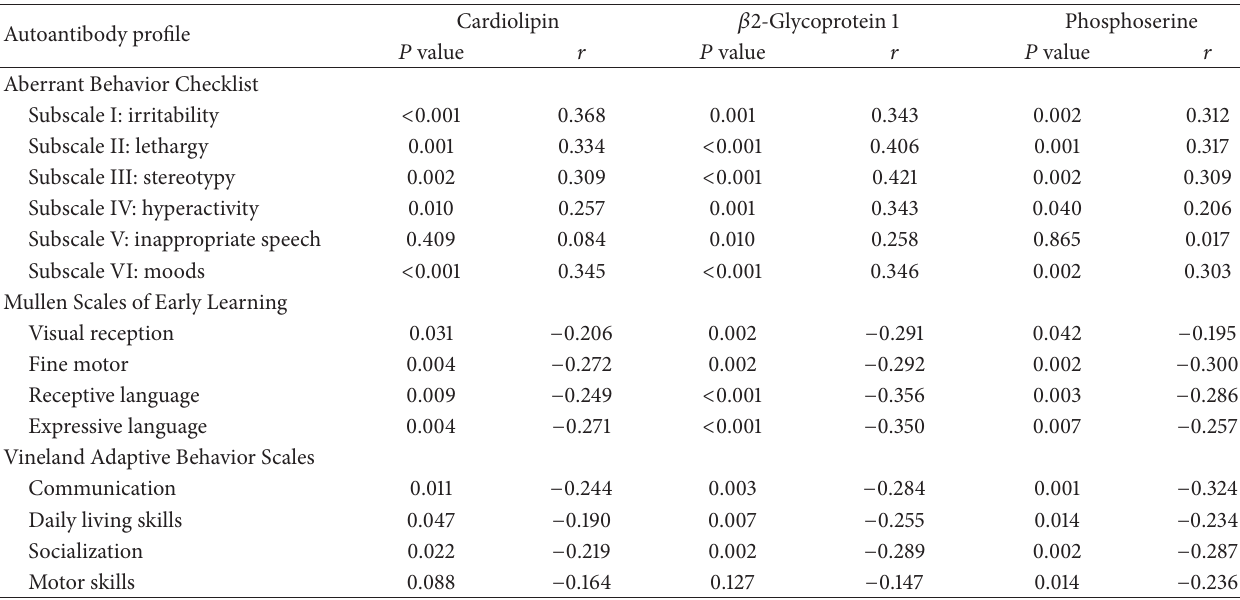
Table 1: Association analysis of anticardiolipin, 𝛽 2-glycoprotein 1, and antiphosphoserine with behavioral outcome measures as assessed by the Aberrant Behavior Checklist (ABC), Mullen Scales of Early Learning (MSEL), and Vineland Adaptive Behavior Scales (VABS) using Spearman’s rank correlations demonstrated that there were significant correlations between anti-phospholipid antibody levels and the severity of impairments in behavior in participants enrolled in this study. For the ABC, a higher score corresponds to more behavioral impairments. For the MSEL and VABS, a lower score corresponds to increased cognitive and adaptive